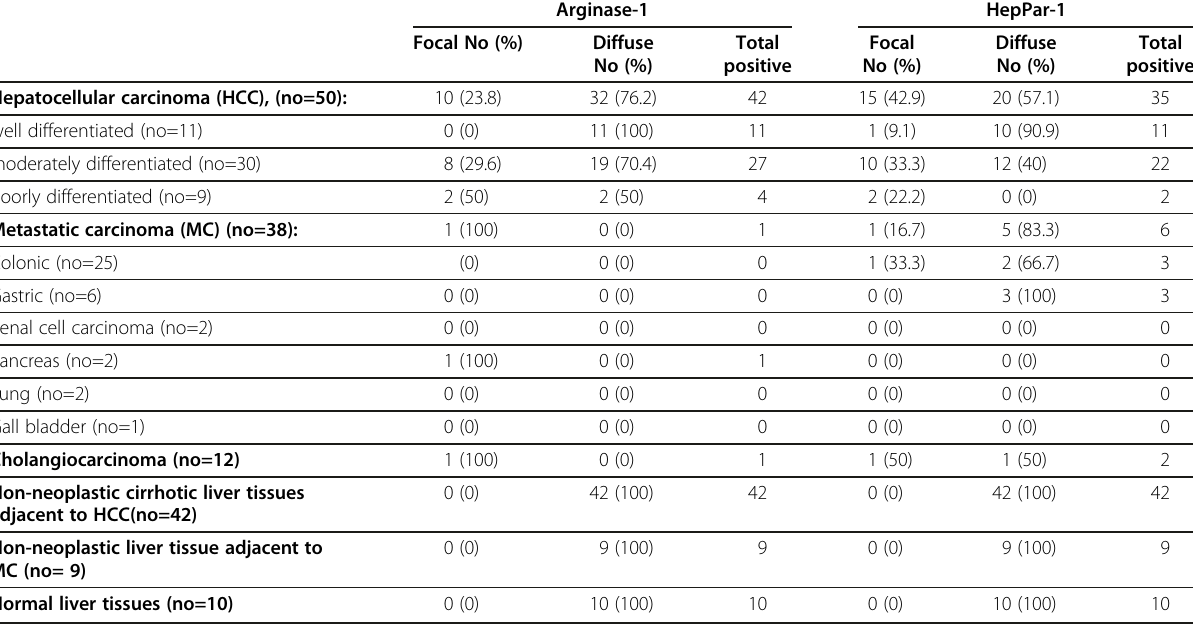
Table 3 Immunohistochemical expression of arginase-1 and HepPar-1 according to the pattern of staining in all positive